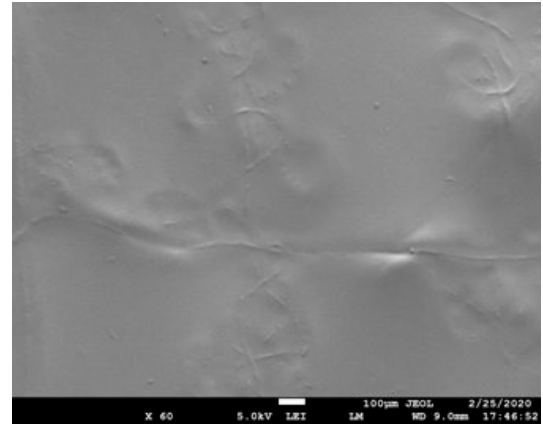
Figure 2. SEM image of the polyvinyl alcohol (PVA) reinforced with PCL fibers. The image shows that the PCL fibers are embedded within the PVA matrix